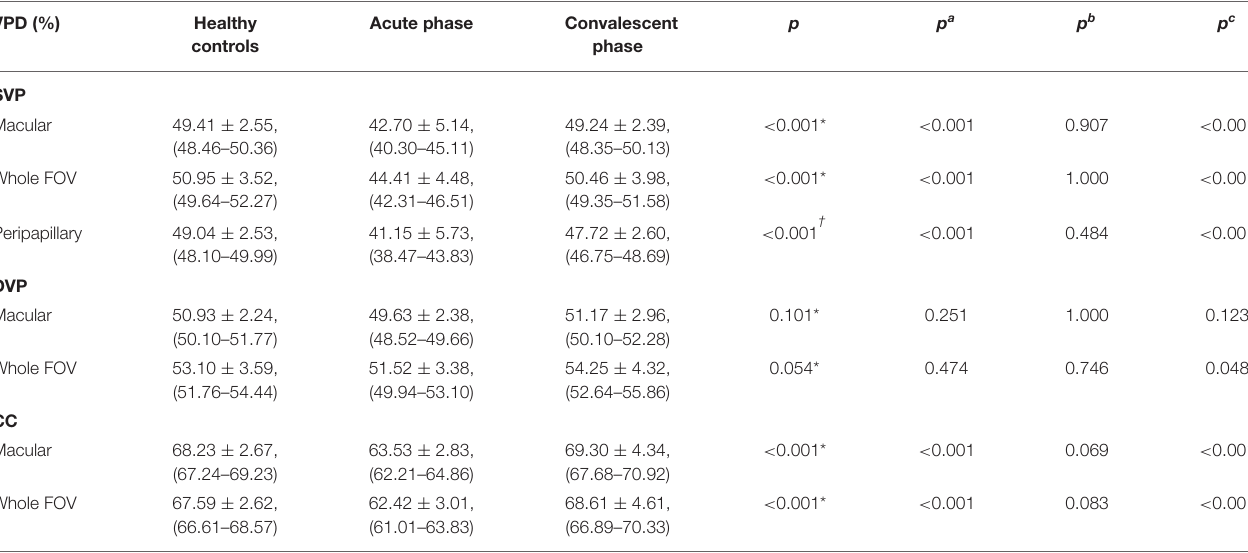
TABLE 2 | The vascular perfusion density (VPD) measurements in different slabs and regions. VPD (%) Healthy Acute controls